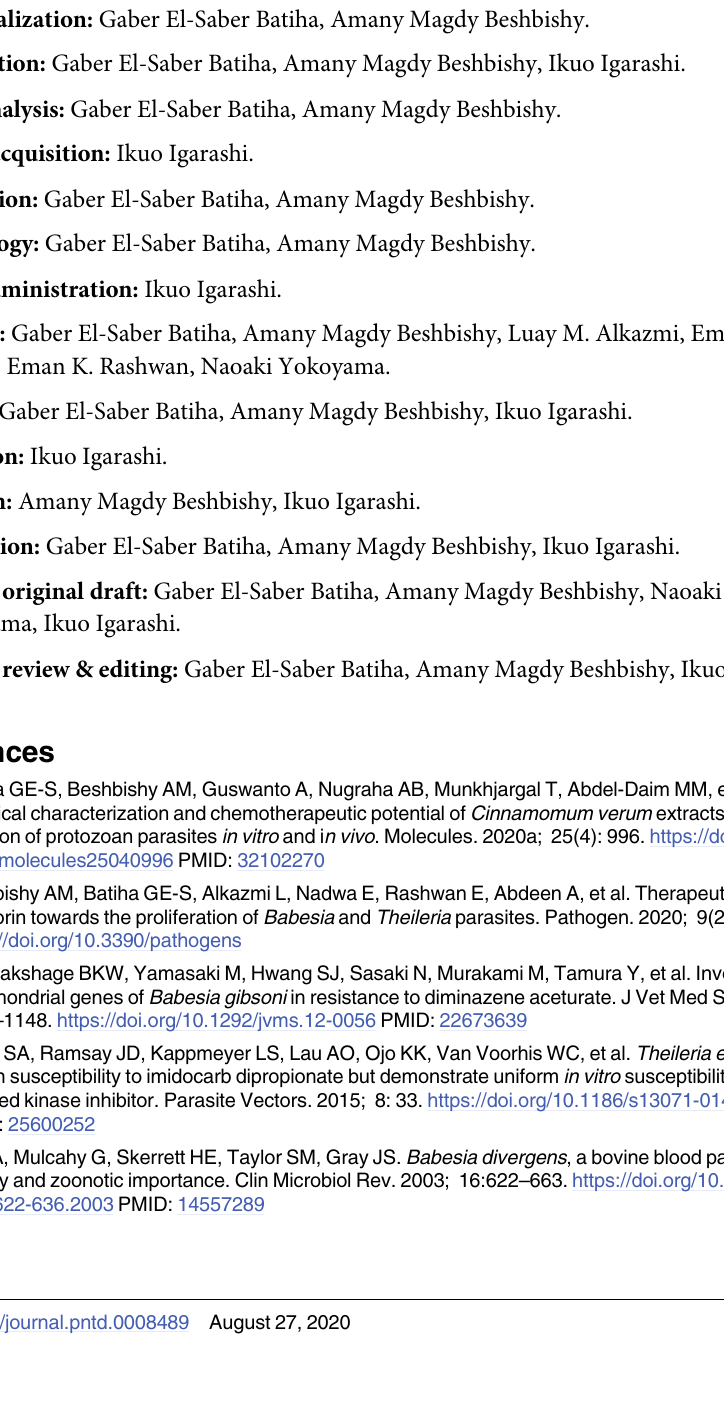
S2 Table. Concentrations of CRY combined with DA, AQ, and CF against four Babesia species and T . equi in vitro